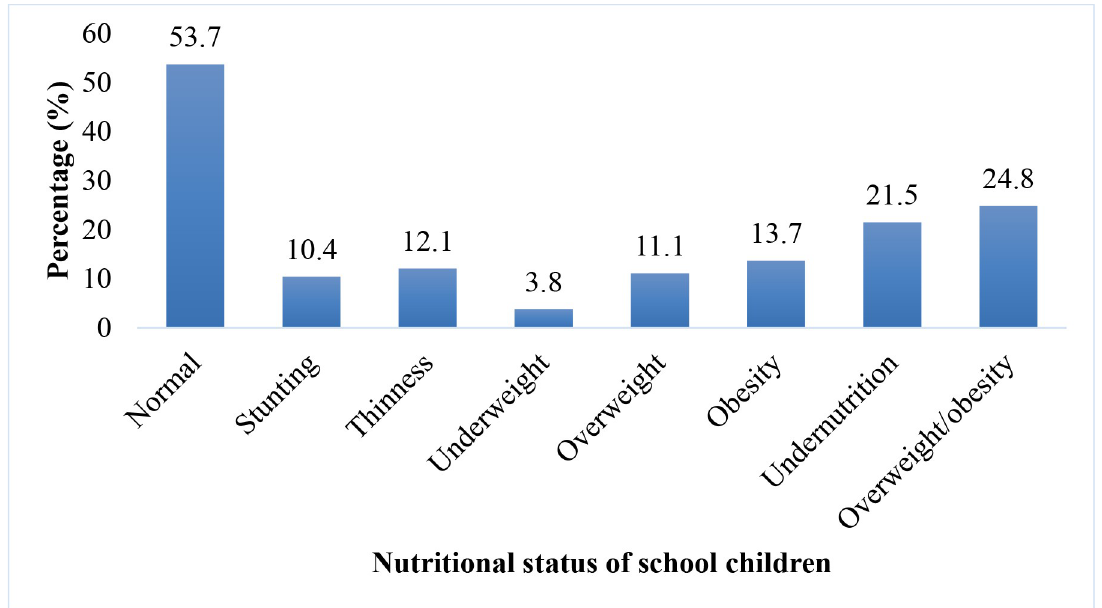
Fig 1. Nutritional status of school children aged 6–12.